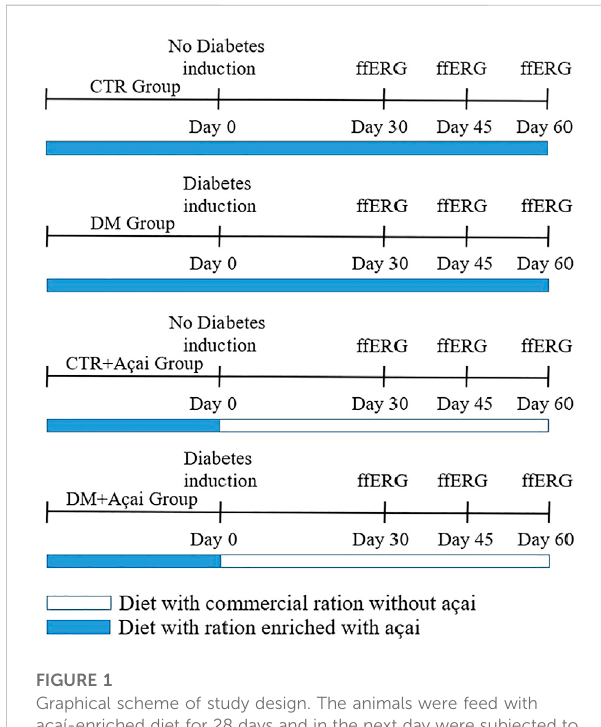
FIGURE 1 Graphical scheme of study design. The animals were feed with açaí-enriched diet for 28 days and in the next day were subjected to diabetes induction (Day 0). Then, ffERG (full fi eld